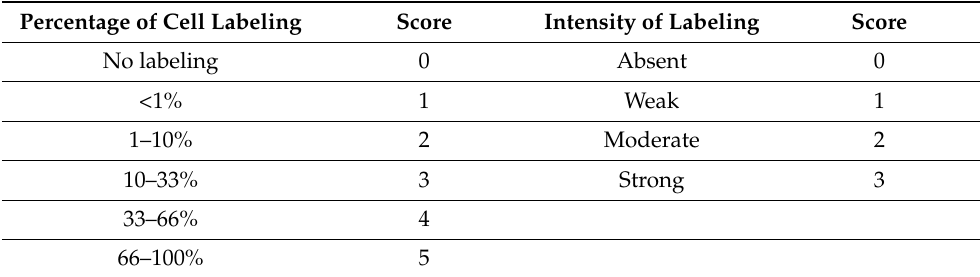
Table 1. Allred scoring system for ER α immunohistochemical analysis